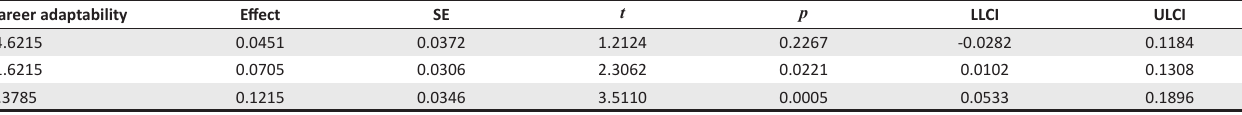
TABLE 8: Conditional effects of the focal predictor at values of the